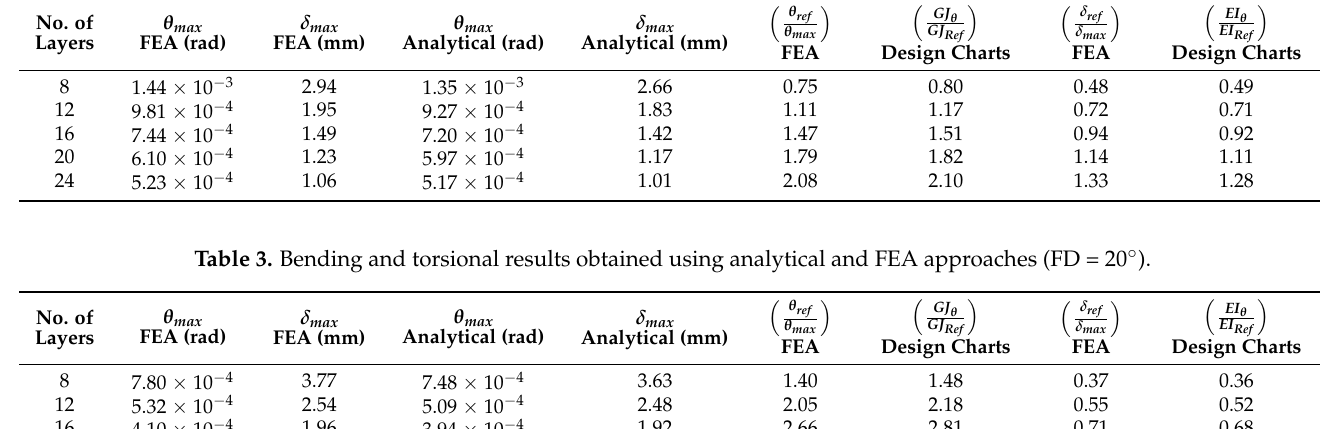
Table 2. Bending and torsional results obtained using analytical and FEA approaches (FD = 10 ◦ ). θ max No. of FEA (rad) Layers